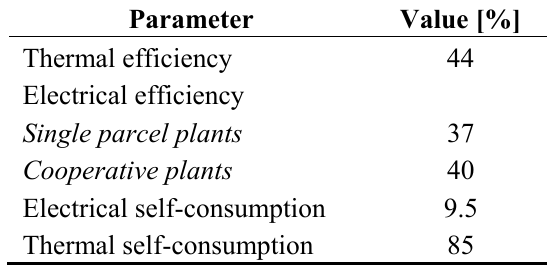
Table 5. Parameters that characterize the conversion